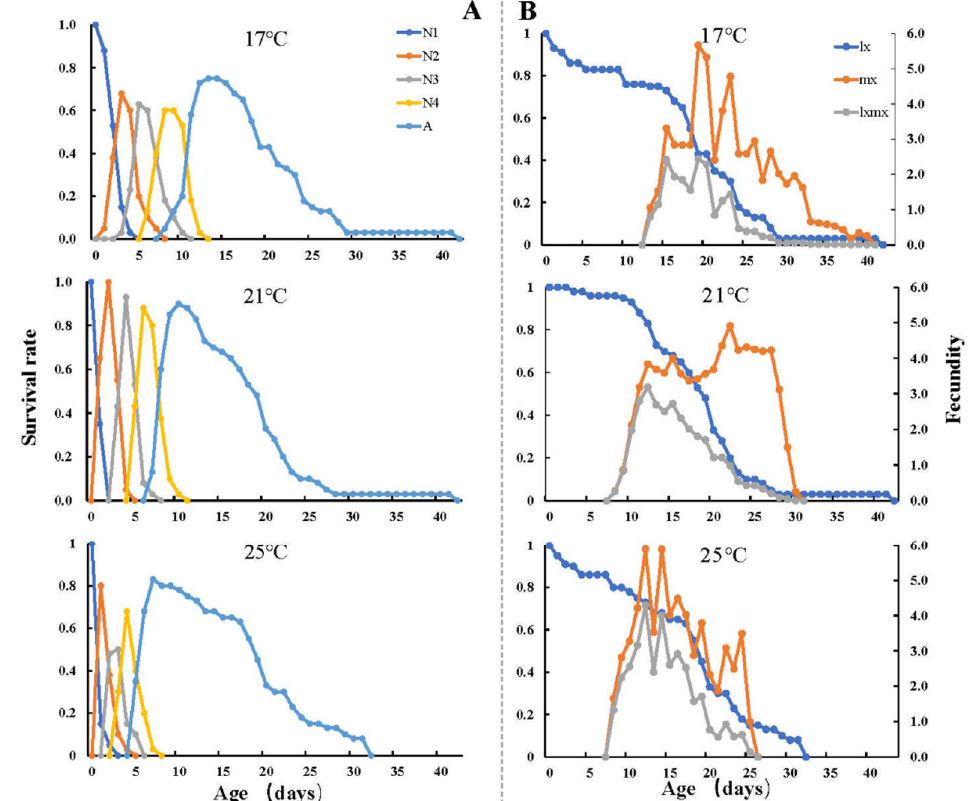
Figure 1. The age-stage-specific survival rate and age-specific fecundity of Uroleucon formosanum under different temperatures. ( A ) the age-stage-specific survival rate of U. formosanum under different temperatures. ( B ) the age-specific fecundity of U. formosanum under different temperatures. N1, first instar nymph; N2, second instar nymph; N3, third instar nymph; N4, fourth instar nymph; A, adult; lx, age-specific survival; mx, age-specific fecundity; lxmx, age-specific maternity.